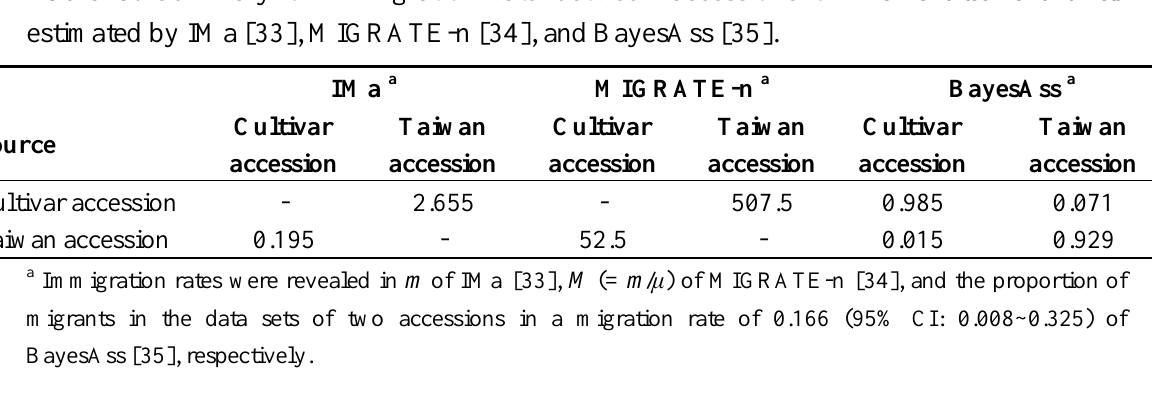
Table 5. Summary of immigration rate between accessions of Momordica